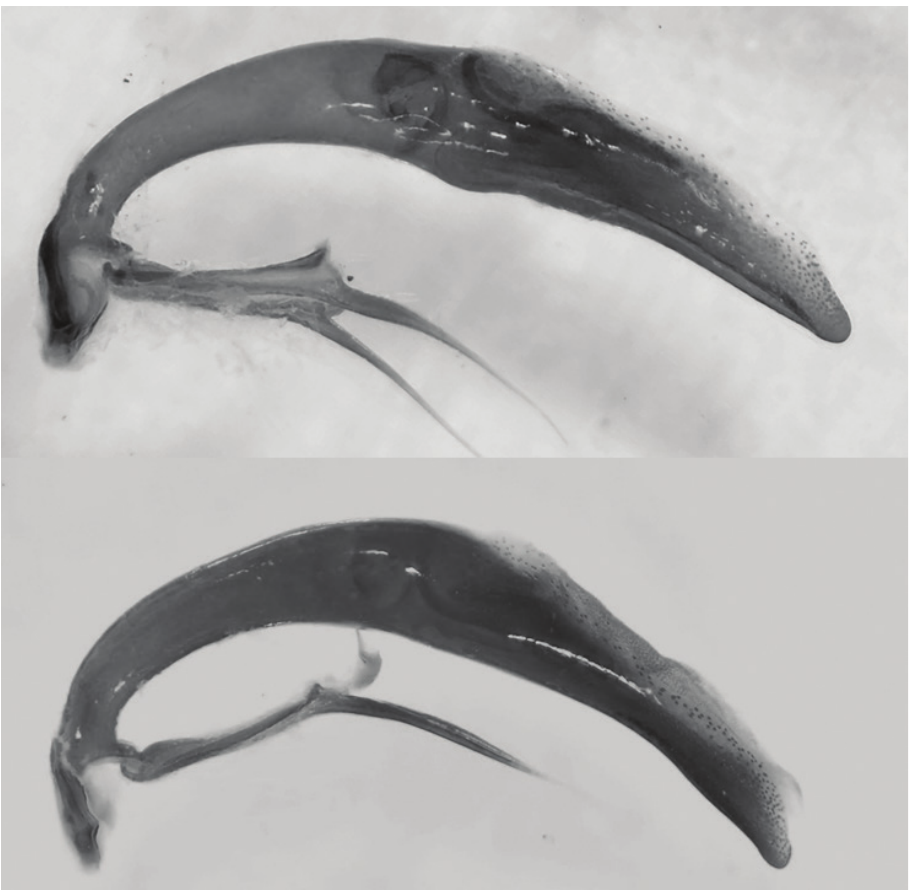
Figure 41. Median lobes of the aedeagus of species of Calomera aulicoides (above) and C. littoralis winkleri